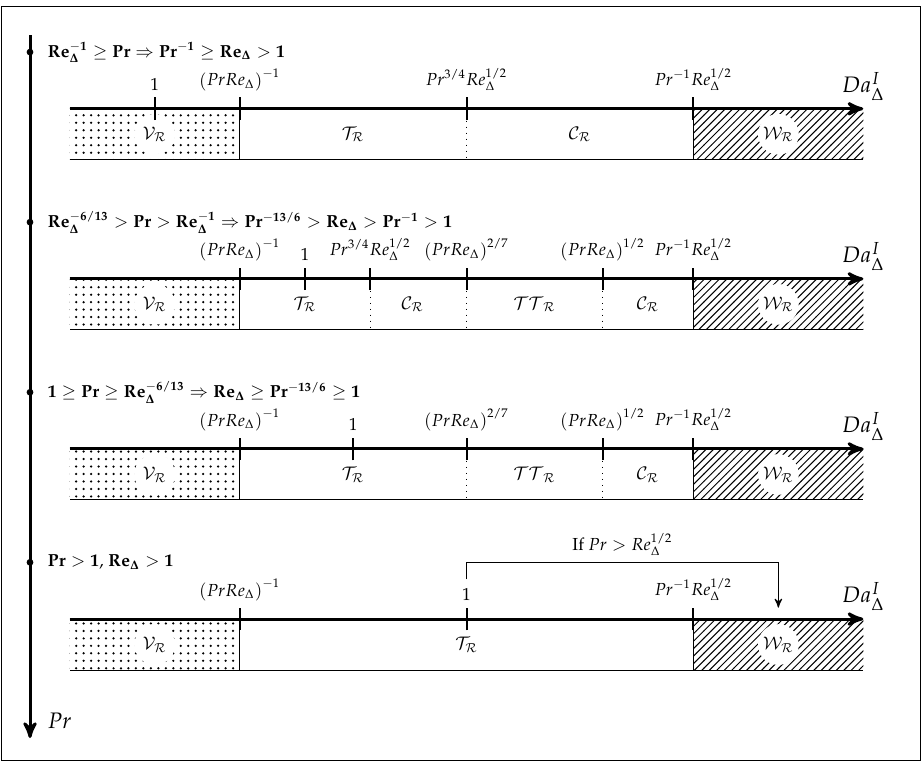
Figure 4. Turbulent combustion regimes and their boundaries in the LTSM